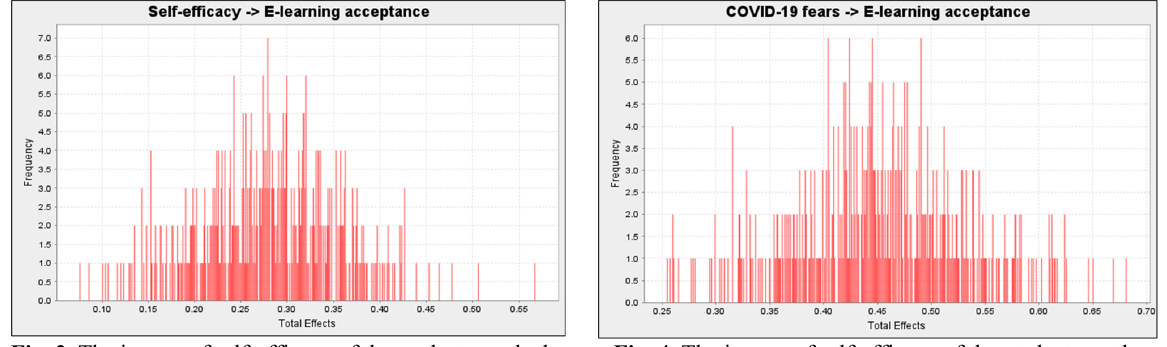
Fig. 4. The impact of self-efficacy of the students on the behavioral intention to adopt e-learning